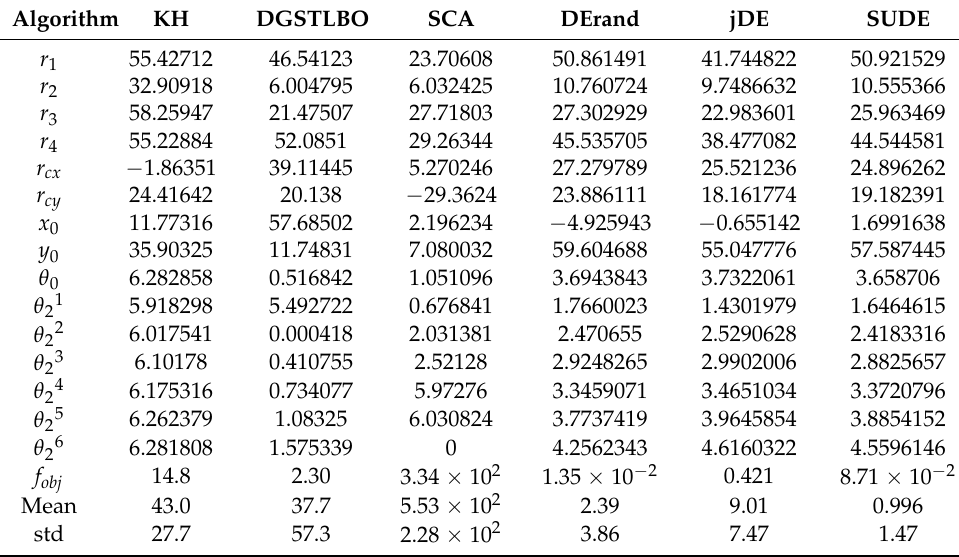
Table 7. The results of the four-bar mechanism with the six